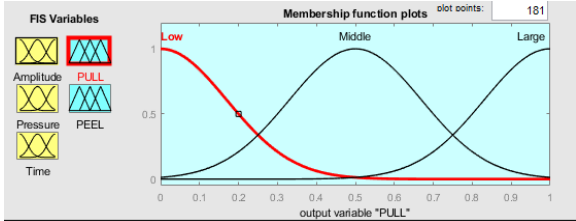
Fig 3. Membership function for individual responses